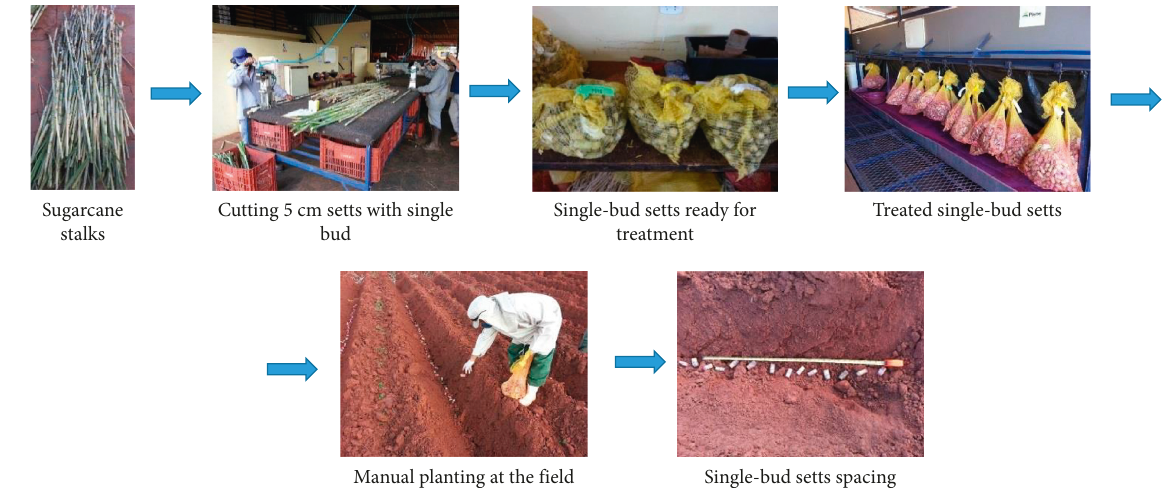
Figure 1: Process for SBS (single-bud sett) production and planting.